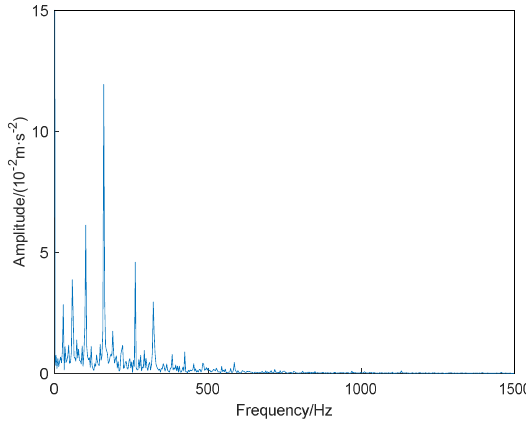
Figure 17. The envelope spectrum of the optimal component. The 162.1852 Hz multiplier frequency component does not appear in the graph; thus, it is not possible to determine that 162.1852 Hz is the fault frequency. The frequency band [44,103] was chosen as the frequency range for solving T. Next, use SSA to adaptively optimize the parameters of MCKD, and obtain the required filter length, impulse signal period, and shift number parameter combinations as L 0 = 575, T 0 = 78, and M 0 = 4. The curve of the change in the value of the fitness function with the number of iterations of population evolution is shown in Figure 18.